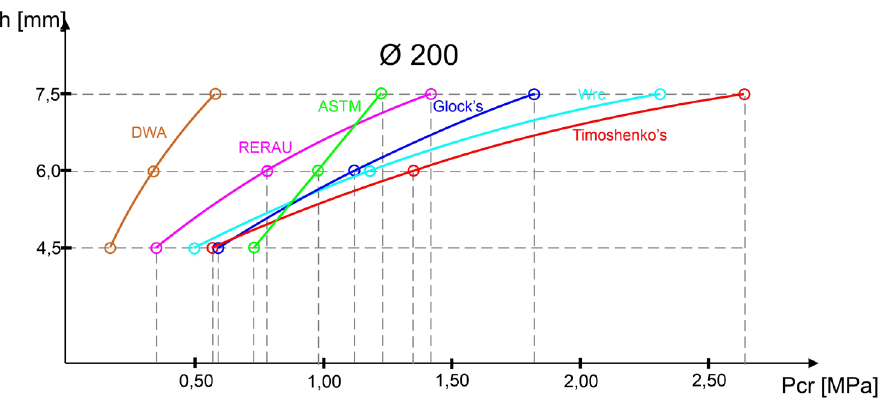
Figure 4: The value of critical pressure p